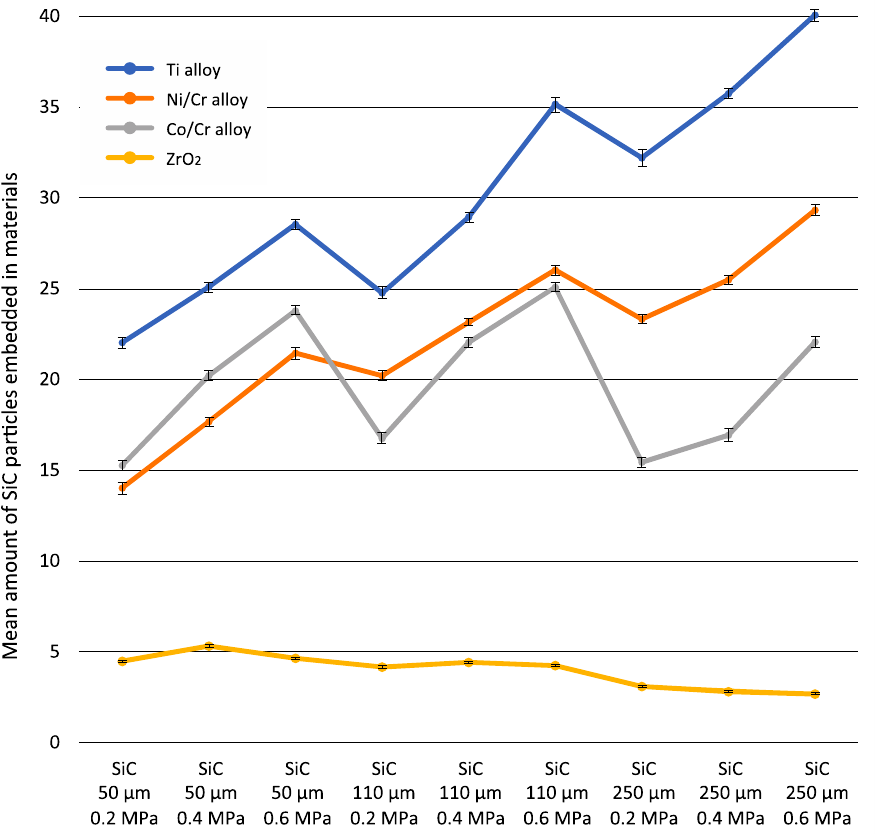
Figure 3. The amount of SiC particles embedded in the four different test materials according to abrasion parameters.